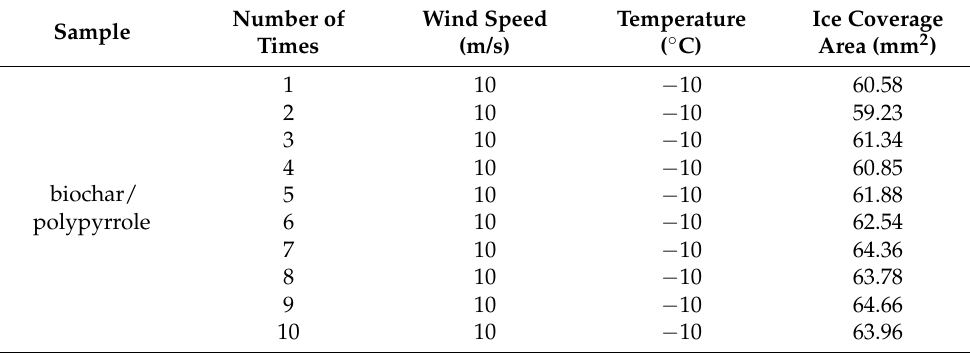
Table 4. The icing area of biochar/polypyrrole coating after ten wind tunnel icing tests.